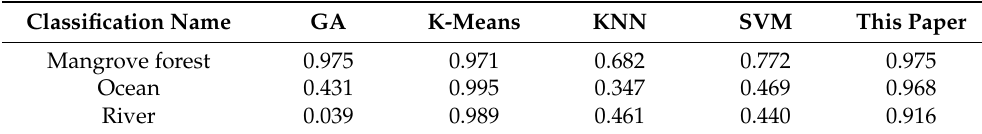
Figure 15. Output results for Data 2. Table 4. Test Results for IoU Parameter (Data 2).